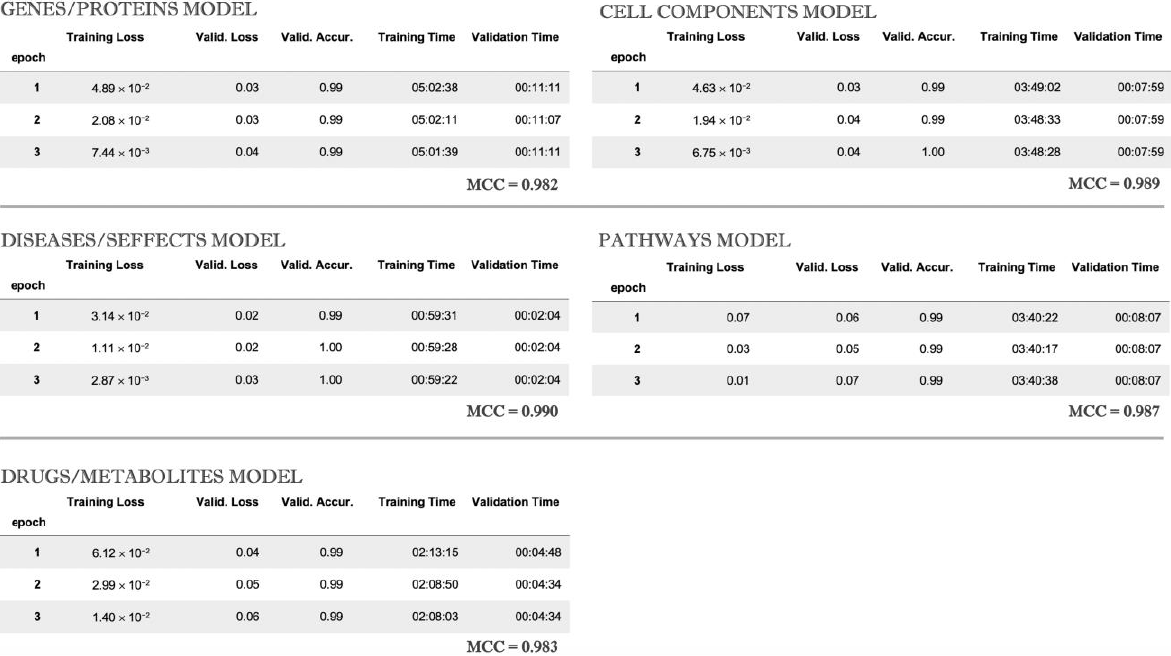
Figure 2. The classification model’s training results for each selected group.